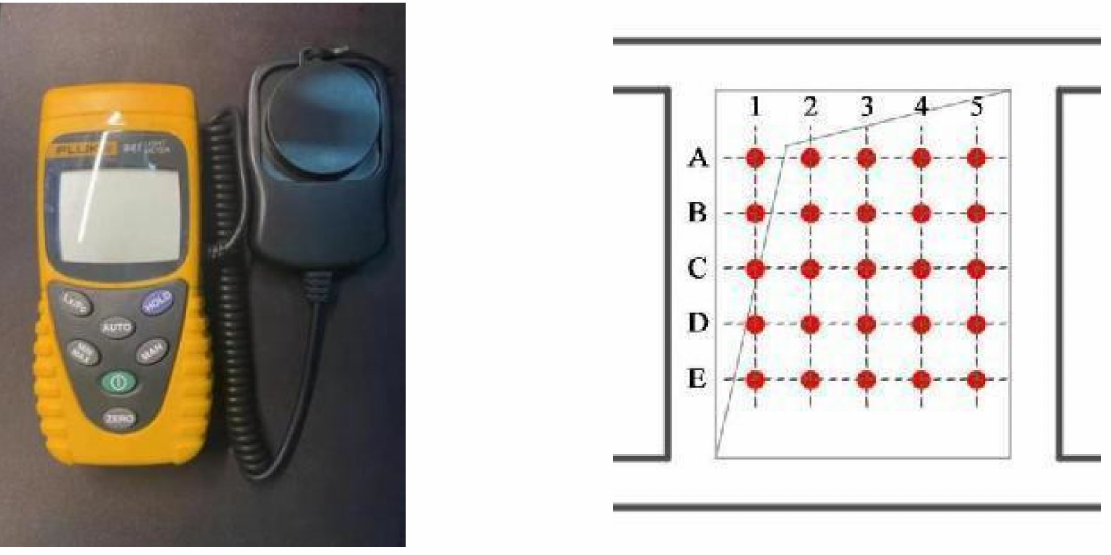
Figure 4. Test equipment and measuring point layout.